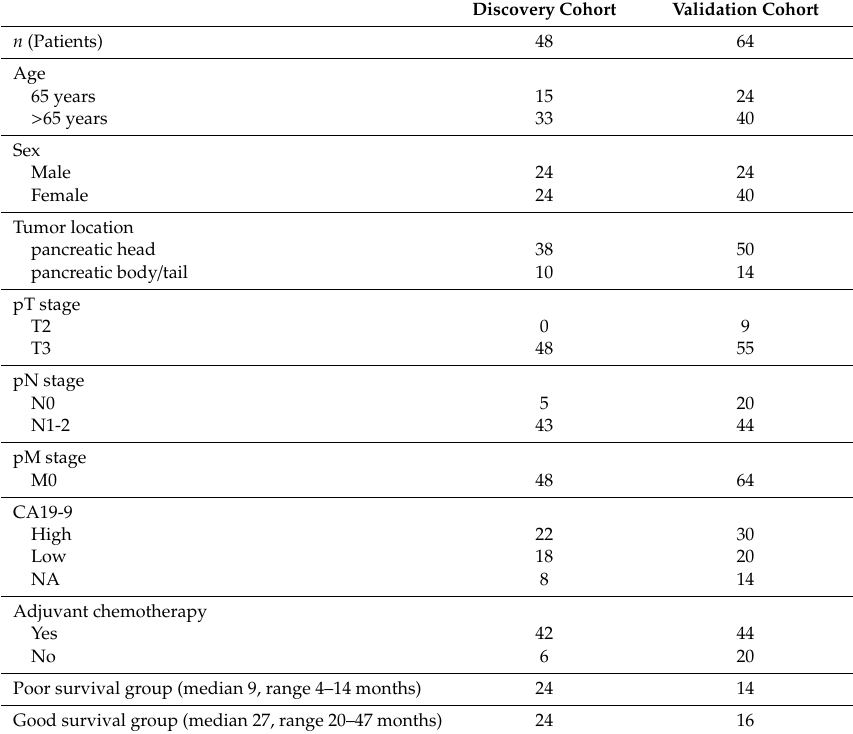
Table 1. Clinical and histopathological characteristics of pancreatic ductal adenocarcinoma patients. Discovery